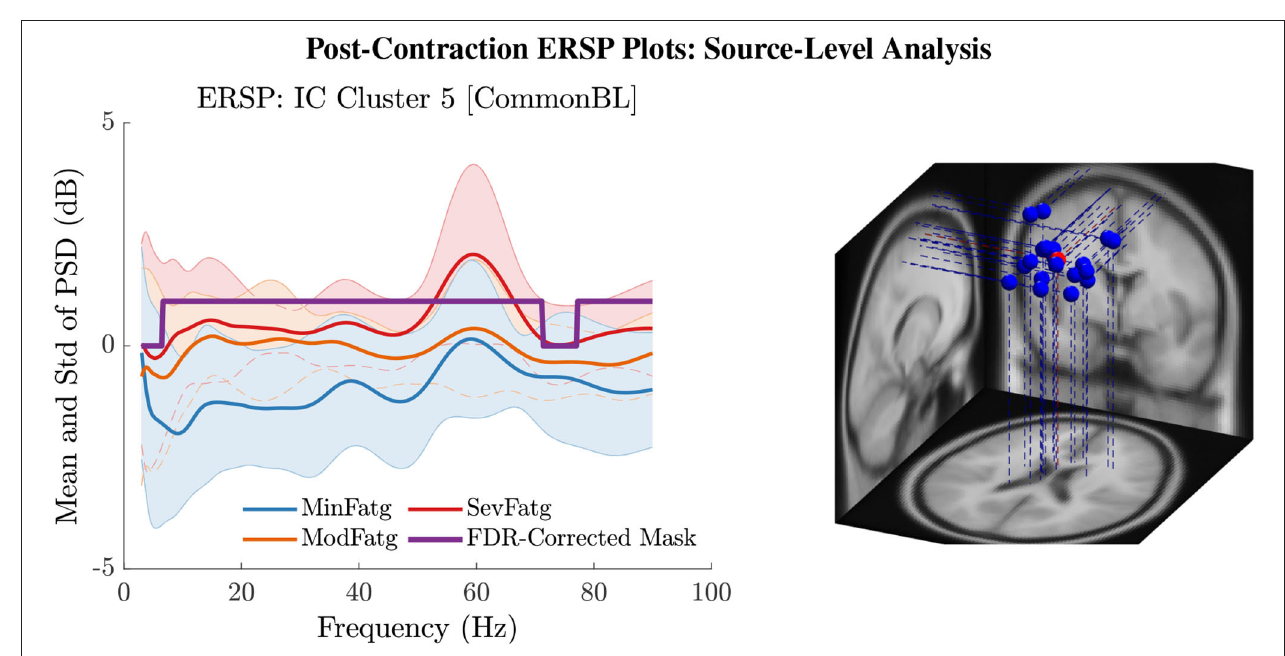
FatgCond FIGURE 9 | The post-contraction ERSP averaged over time, ∼ ERSP , shows the PSD variations across the fatigue conditions for the frequency range 3Hz to 90Hz in IC Cluster 5 (left panel). The FDR-corrected mask indicates that the time-averaged ERSP differs between fatigue levels with a statistical significance ( p < 0.05) in the entire frequency range except in the delta and high gamma band. The equivalent dipoles corresponding to ICs (blue dots) in Cluster 5 and its centroid (red dot) are seated within the right paracentral lobule or SMA (right panel).